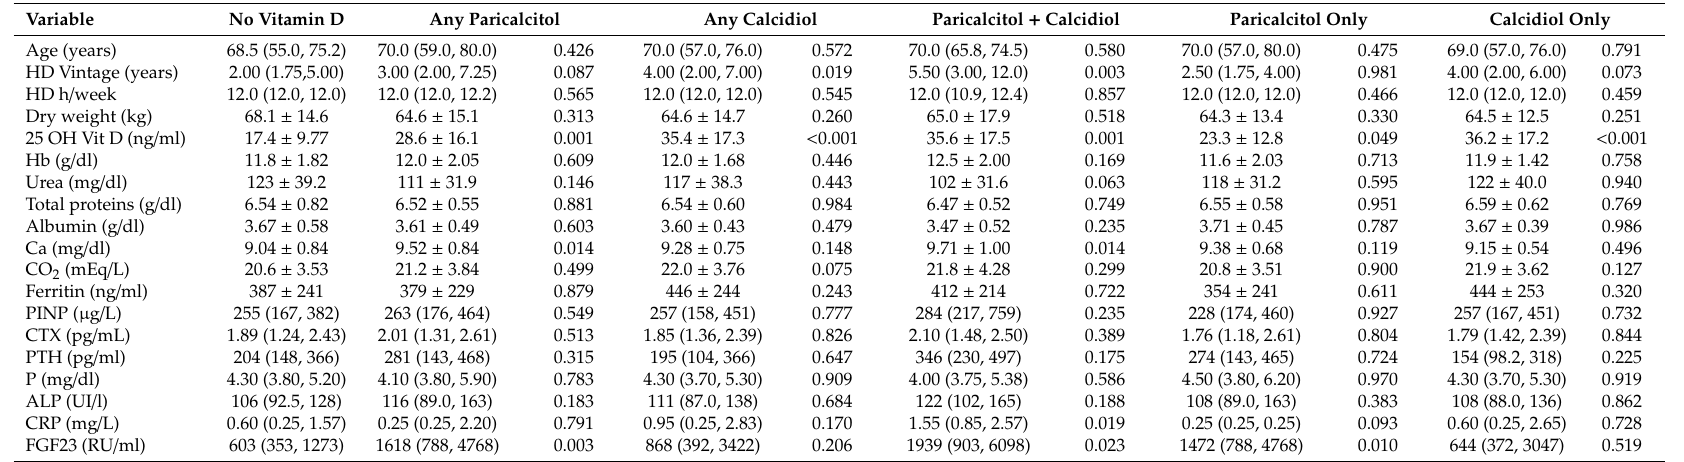
Table 3. Biochemical parameters and vitamin D therapy. For variables with normally distributed data, the mean, standard deviation (SD) and Student’s t-test were used to describe and compare the data. For variables with non-normally distributed data, the median, interquartile range (p25, p75), and Mann–Whitney test were used.